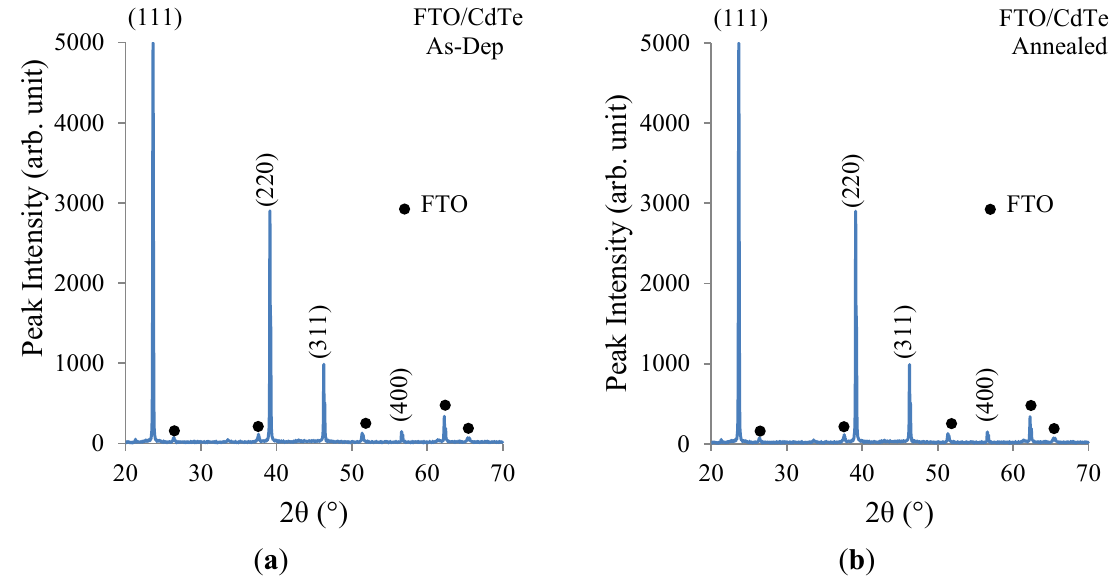
Figure 21. Typical XRD patterns of CdTe layers in ( a ) Region-1 and ( b ) Region-2. XRD patterns in Region-2 can have three or four peaks with varying intensities depending on the substrates used, growth conditions and post-growth processing